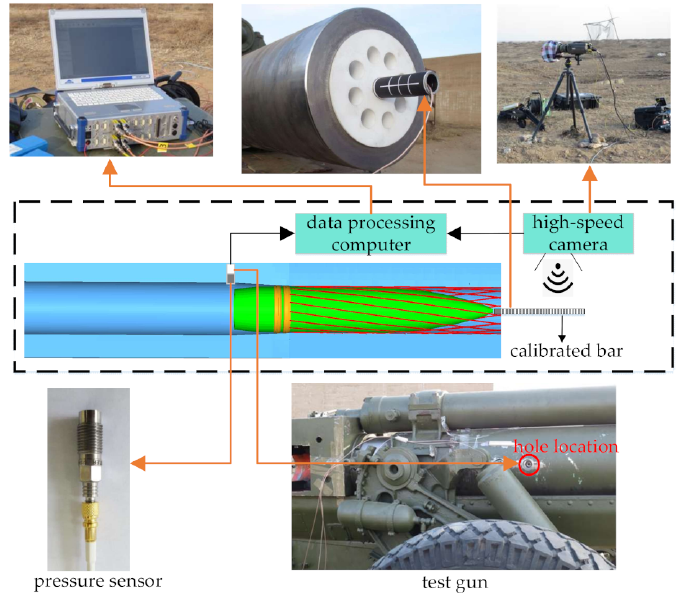
Figure 5. Schematic diagram and the physical picture of real gun launch experiment.